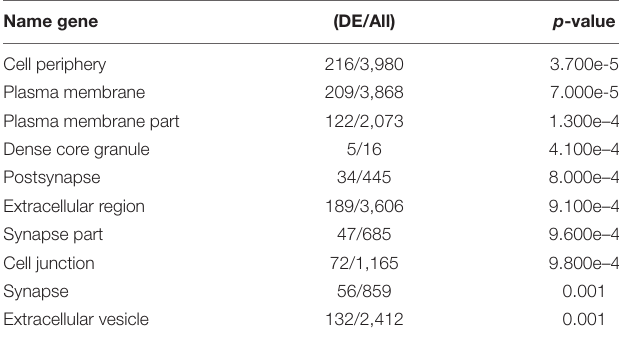
TABLE 3 | Top 10 GO term summary (cellular components) between PND 40 and PND 16 large